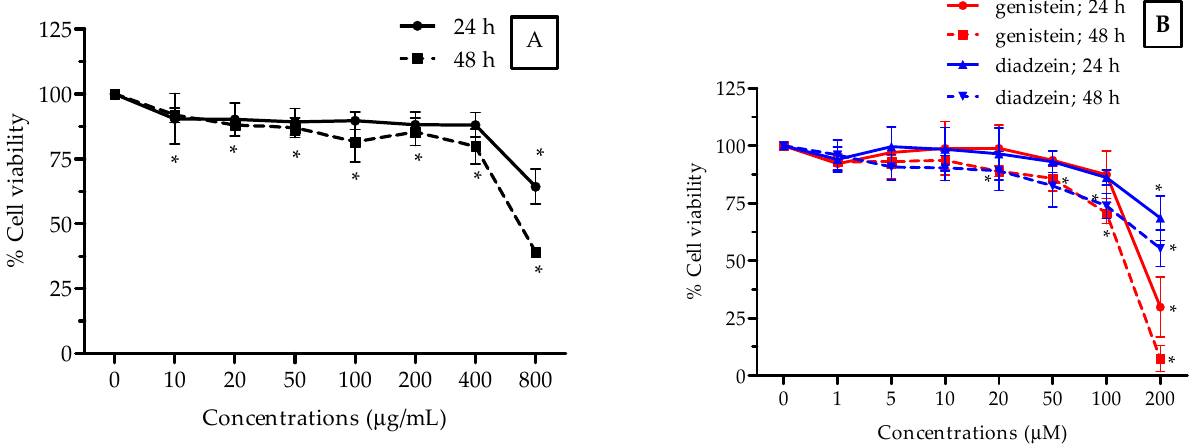
Figure 3. Cytotoxicity activity of the ethanolic isoflavone extracts from Thua-nao ( A ) and genistein and diadzein ( B ) at various concentrations in MCF-7 cells for 24 h and 48 h of incubation. All results are presented as the mean ( n = 3) ± SD. * p < 0.05 compared to the nontreatment control in each incubation time. Table 3. Cytotoxic activity of ethanolic isoflavone extracts from Thua-nao in various cancer cells.